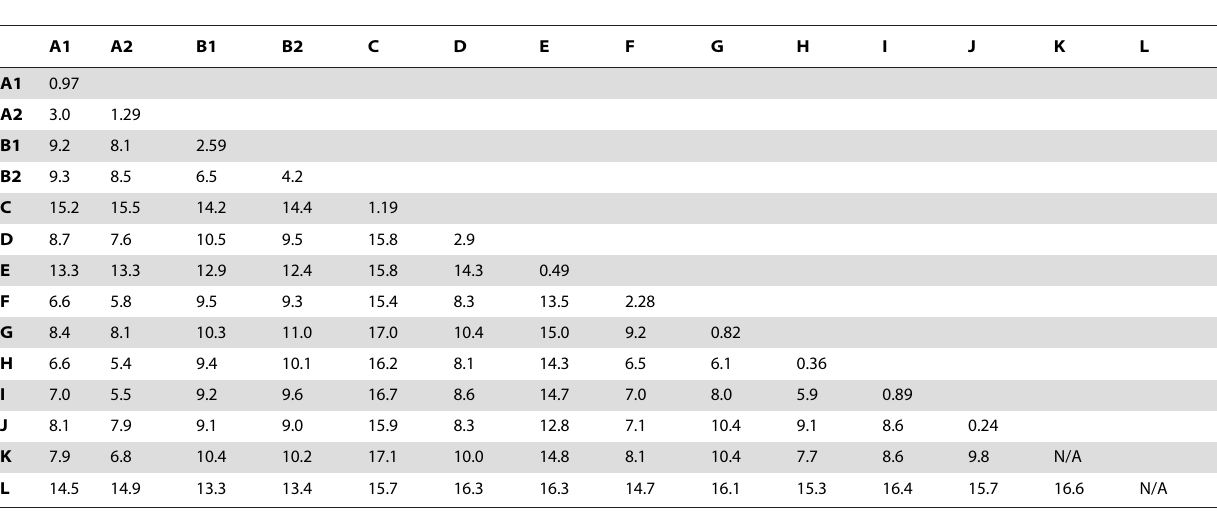
Table 2. Evolutionary divergence between major clades of the P. piseki–P. gracilis species